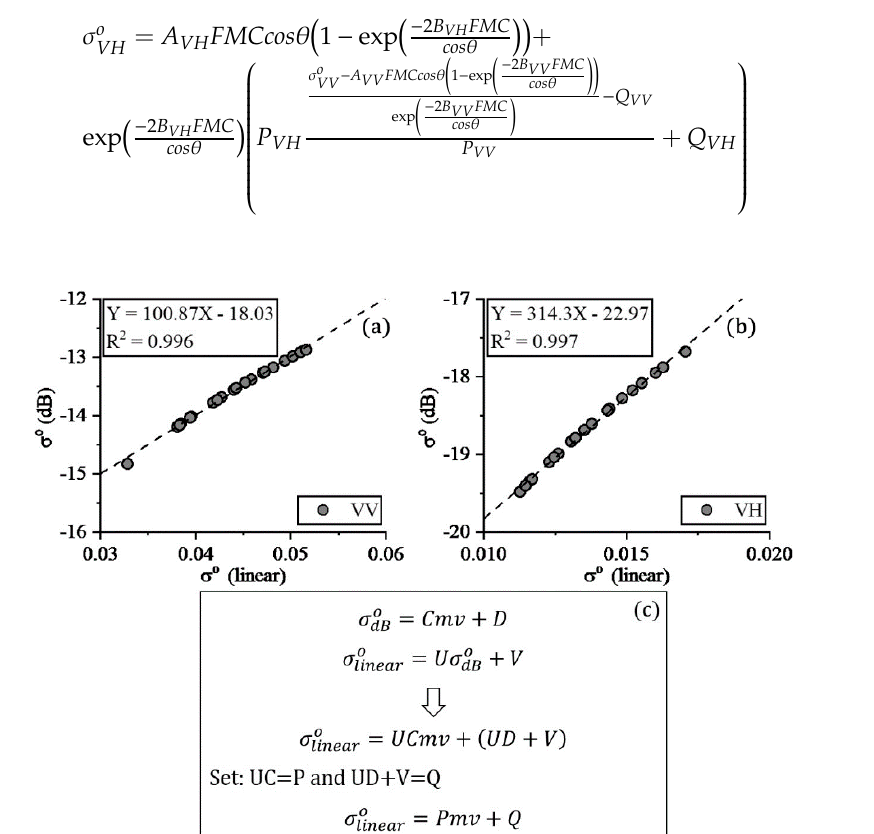
Figure 5. Linear relationship between backscatter in dB unit and that in linear unit over a small variation range for VV ( a ) and VH ( b ) polarization mode, and corresponding conversion formulas ( c ) used to reduce the model complexity.